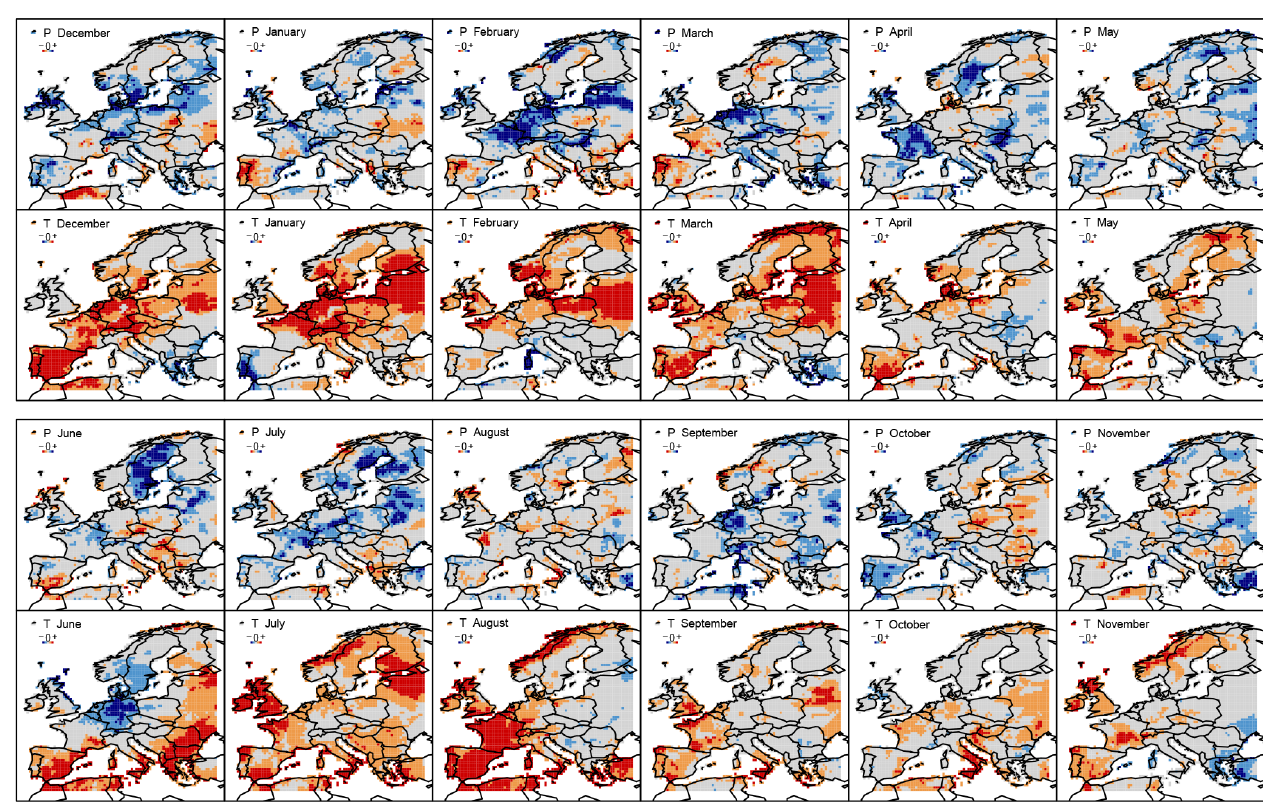
Figure 4. Monthly trends within the groups of wet STs for precipitation (rows 1 and 3) and temperature (rows 2 and 4) significant at the 70% (light colours) and 95% (dark colours). Precipitation: increasing trends in blue, decreasing trends in red. Temperature: increasing trends in red, decreasing trends in